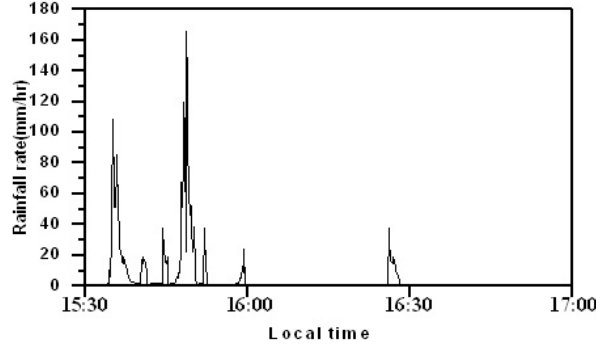
Fig. 8. Rainfall measurements as observed on 15 September 2001.